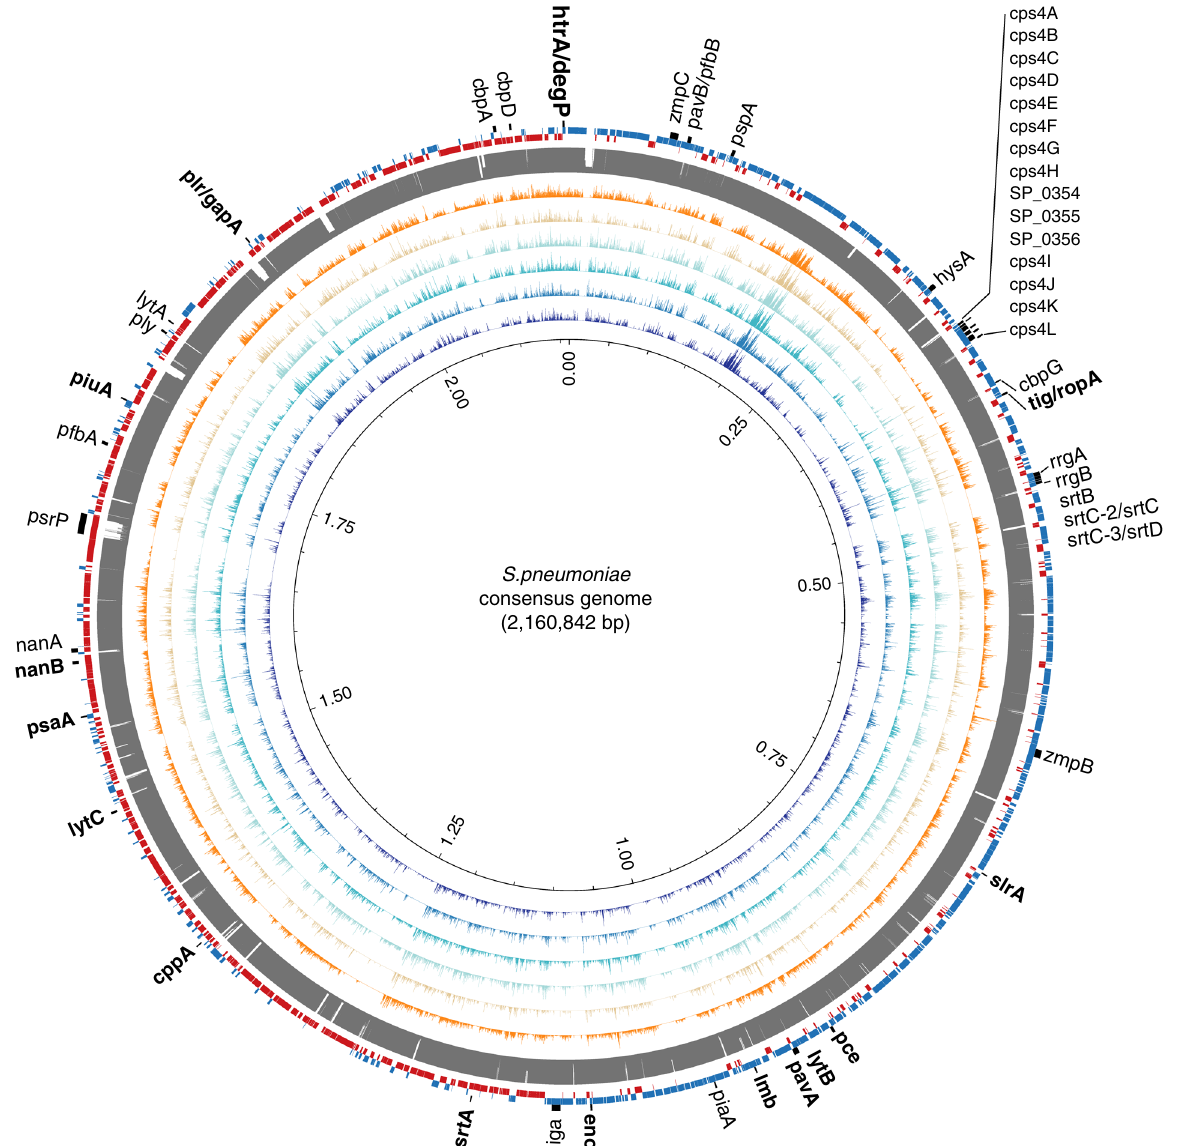
Fig. 4 Streptococcus pneumoniae consensus genome reconstructed from metagenomic sequences recovered from the ancient pitch. From outer to inner ring: S. pneumoniae virulence genes (black, shared genes are shown in bold); S. pneumoniae coding regions on the positive (blue) and negative (red) strand; mappability (grey); sequence depth for the Syltholm pitch (orange), HOMP sample SRS014468 (light brown), SRS019120 (light blue), SRS013942 (turquoise), SRS015055 (blue), and SRS014692 (dark blue). Sequence depths were calculated by aligning to the S. pneumoniae TIGR4 reference genome and visualised in 100 bp windows using Circos 73